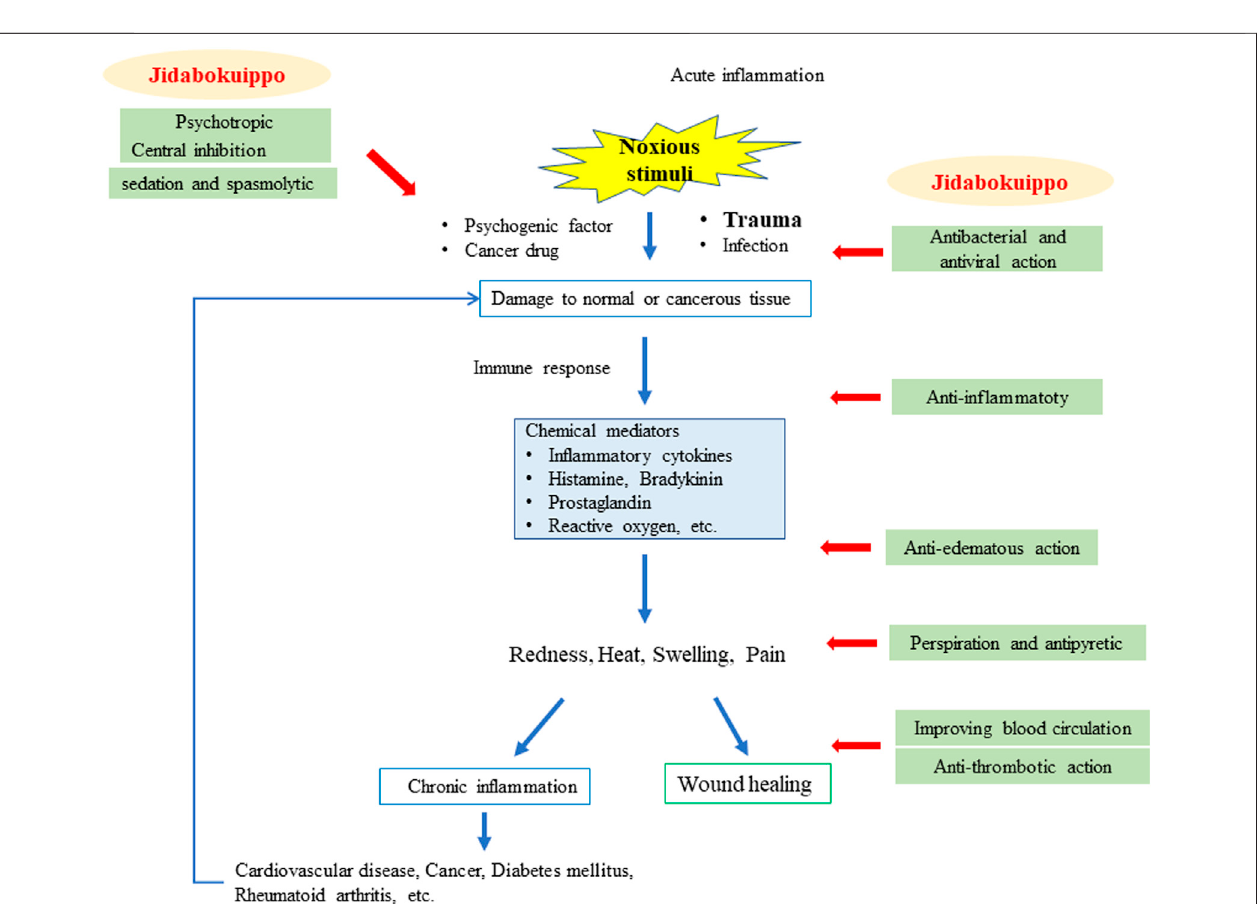
FIGURE 2 | Hypothetical mechanisms of jidabokuippo for acute and chronic in fl ammation.